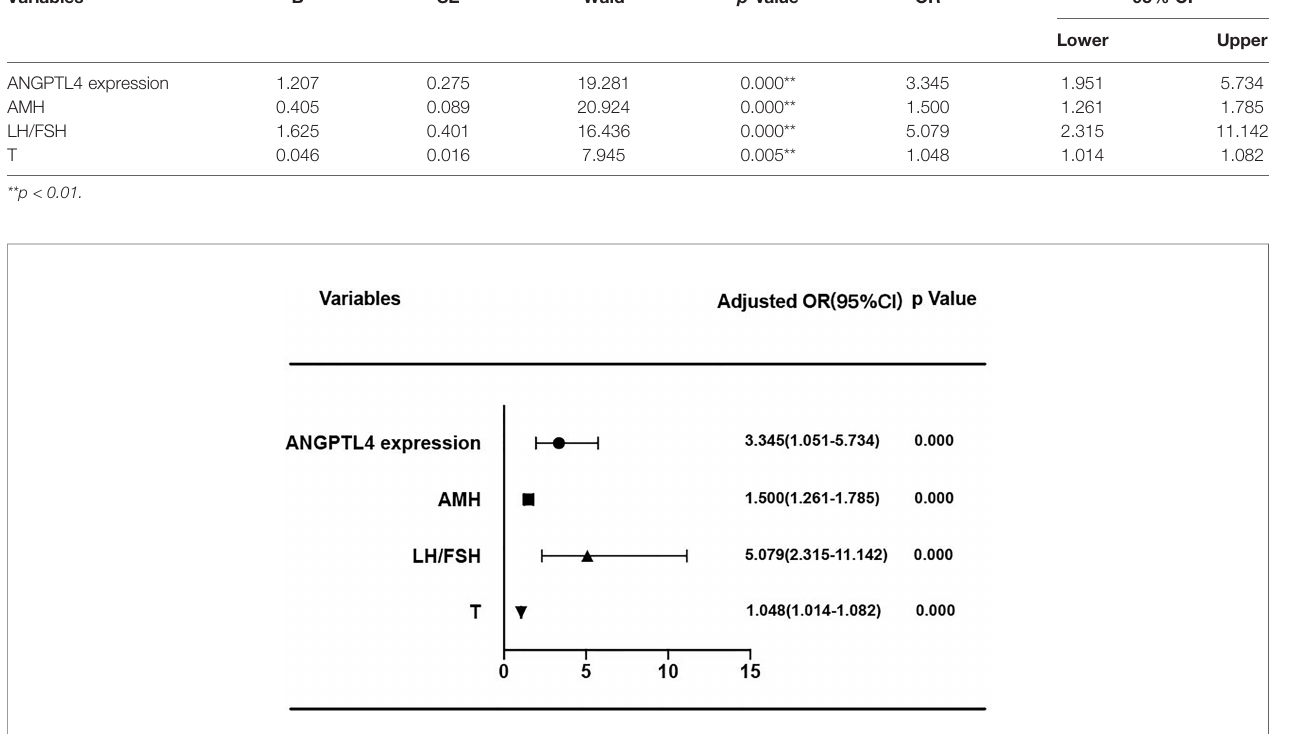
FIGURE 5 | Forest plot of PCOS risk factors. ANGPTL4 expression level were normalized to GAPDH.